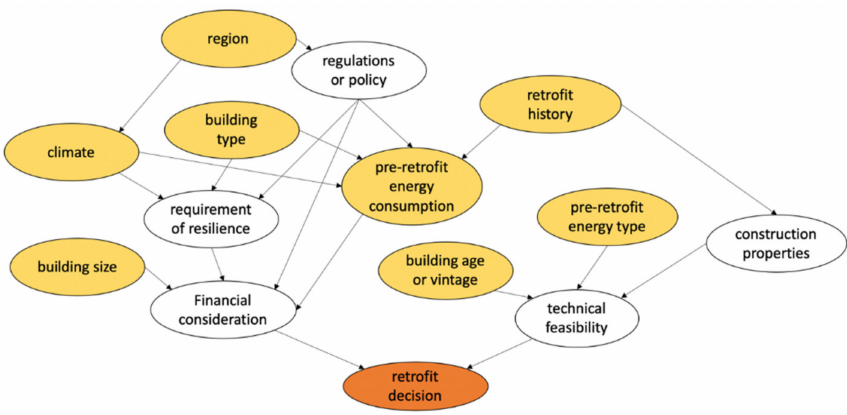
Figure 4. Retrofit decision determinants (variables in yellow are the control